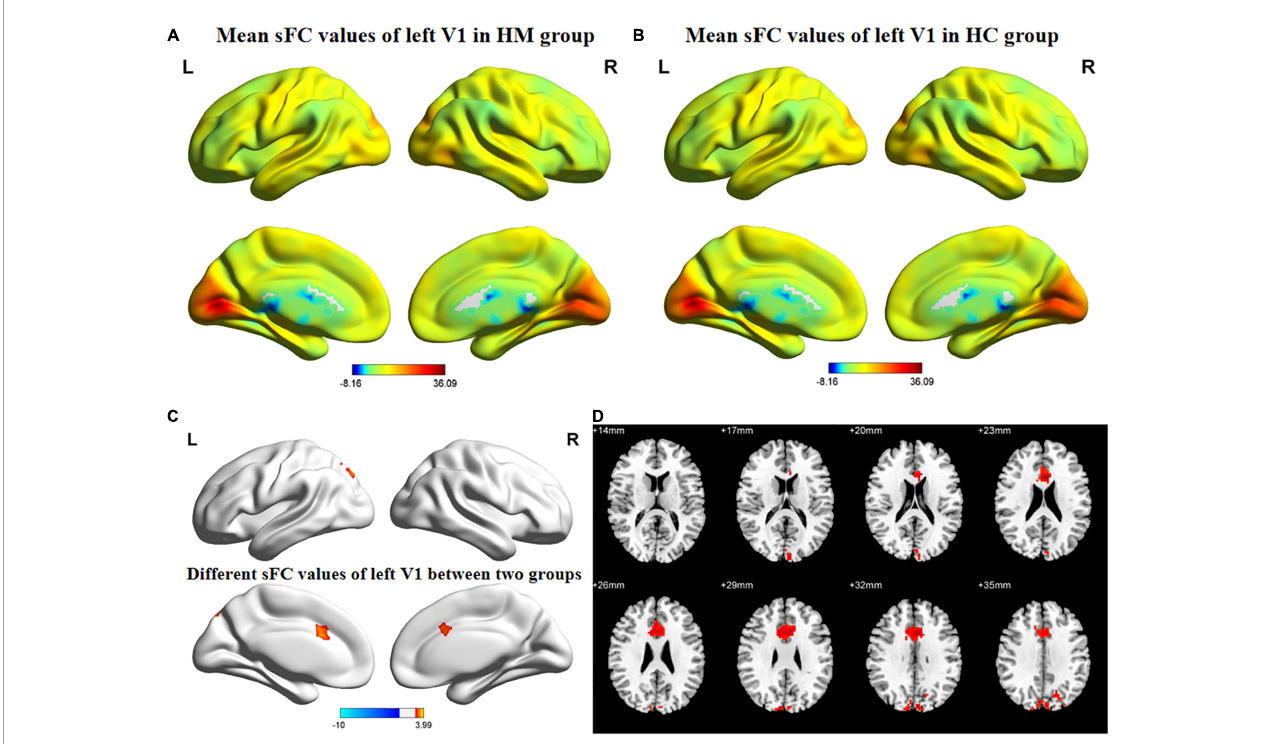
FIGURE1 Spatial of distributions of sFC patterns of the left V1 in HM patients and HCs. (A) Mean sFC values of left V1 in HM group; (B) mean sFC values of left V1 in HC group; (C) different sFC values of left V1 between two groups and (D) significant zsFC maps of left V1 differences among two groups. HCs, healthy controls; HM, high myopia; sFC, static functional connectivity; zsFC, z-values static functional connectivity; L, left; R, right.